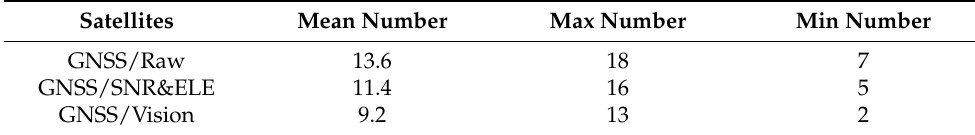
Table 4. Numbers of available satellites for the HK-Data20190426-2